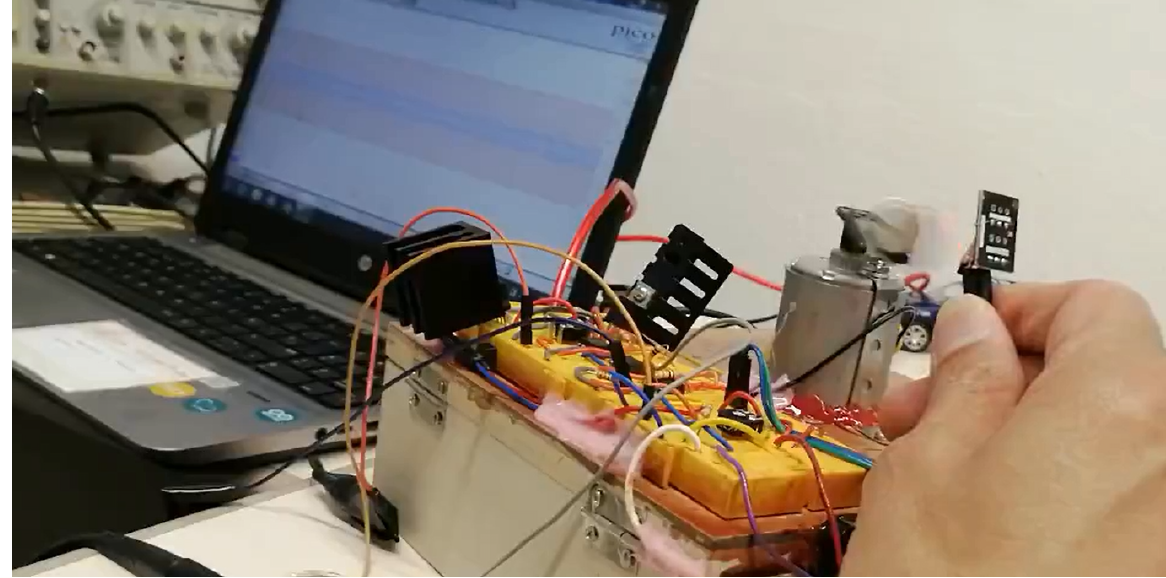
Figure 15. The experimental platform on the